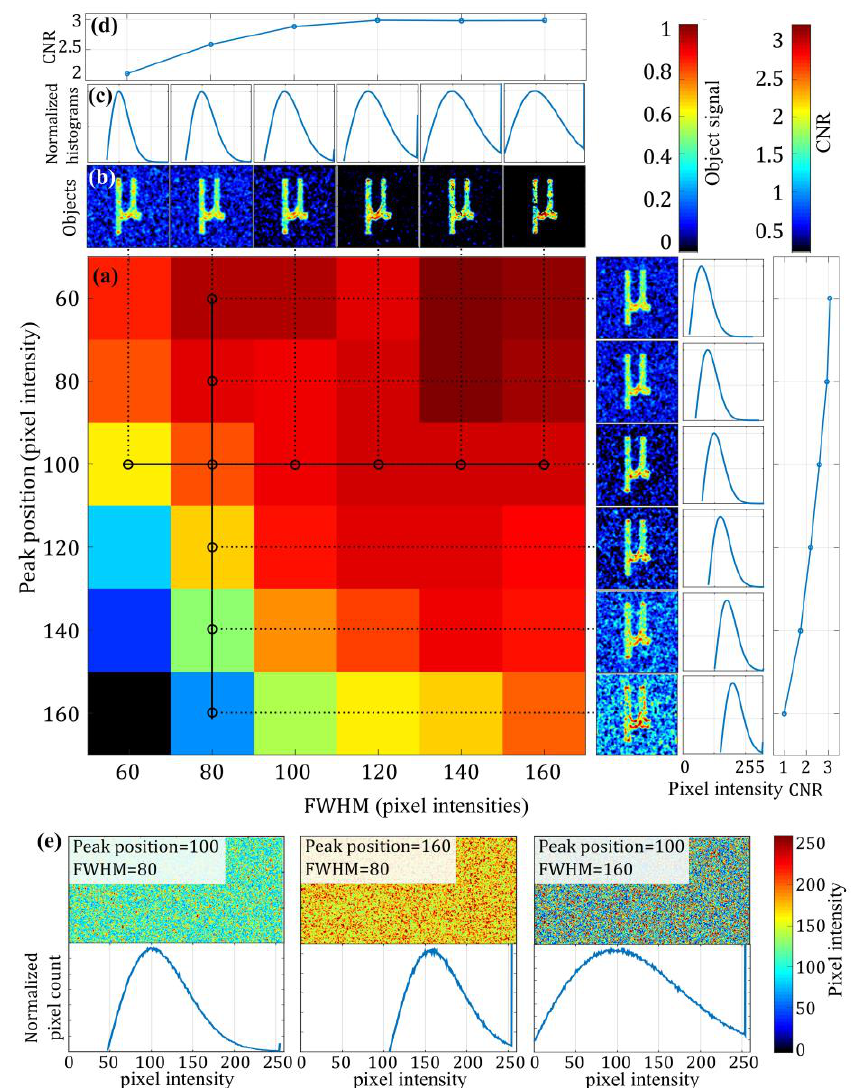
Figure 4. Results of the pixel intensity distribution dependent simulation. The CNR rises nearly continuously with the width of the pixel intensity distribution, whereas the CNR decreases with the increasing peak position of maximum ( a , d ). Parameters matching the experimental data are highlighted with black lines. The corresponding objects ( b ) and pixel intensity distributions ( c ) are plotted and connected with dashed lines. Exemplary speckle patterns for selected parameters ( e ) visualize saturation effects, which lead to information losses at an increasing position of maximum. On the other hand, a broader pixel intensity distribution provides more information for the algorithm to work with.